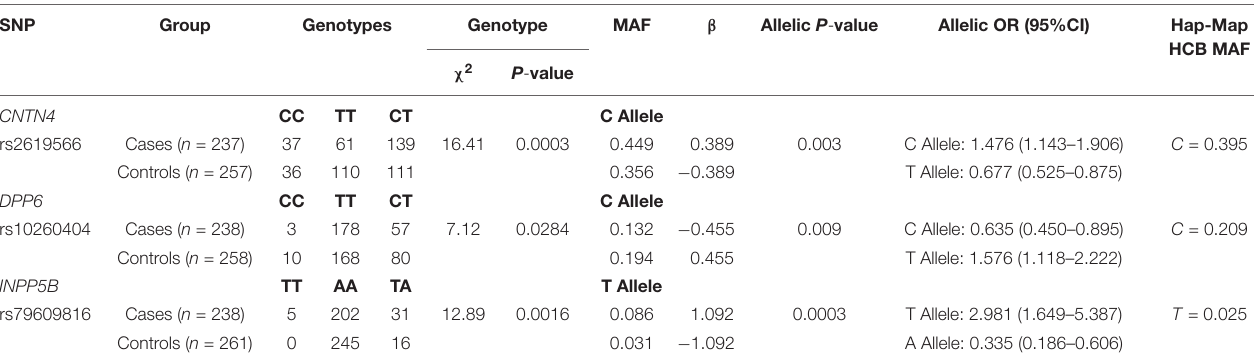
TABLE 3 | Three SNPs shown the nominal significance at P < 0.05 in this study.